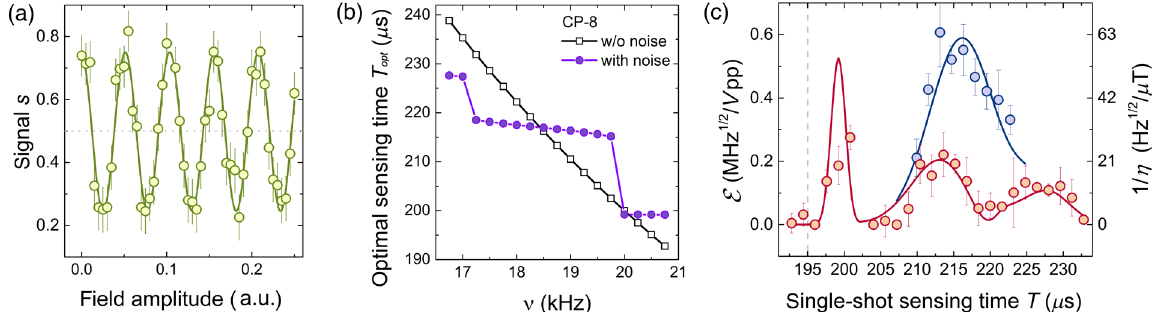
FIG. 2. Optimized sensing of monochromatic fields. (a) Experimental signal measured in the presence of a monochromatic target ac magnetic field, b ð t Þ ¼ b cos ð 2 πν t þ α Þ , with ν ¼ 9 . 24 kHz and α ¼ 0 , as a function of the target magnetic field amplitude b . Here, the spin sensor is controlled with a Carr-Purcell sequence of n ¼ 4 equidistant π pulses. Dots are the experimental data, the curve is a cosinusoidal fit. Error bars are the statistical errors over 2 × 10 5 repeated measurements. (b) Theoretical prediction of the optimal sensing time of a Carr-Purcell sequence of n ¼ 8 equidistant π pulses (CP- 8 ), calculated for a target ac magnetic field b ð t Þ ¼ b cos ð 2 πν t þ α Þ , as a function of the ac frequency ν . The black empty squares are the optimized solutions of the sensing problem when neglecting the presence of the noisy environment, and the black curve represents the expected optimal time, T n= ð 2 ν Þ , with no fitting parameters. Purple dots are optimized solutions including the noise-induced decoherence of the spin qubit opt ¼ (the line is a guide to the eye). (c) Inverse of sensitivity, in the presence of a cosinusoidal field b ð t Þ of frequency ν 0 ¼ 20 . 5 kHz under CP control, with α ¼ 0 (in red), and with α ¼ 102 ° (that is, an initial delay time t 0 ¼ 0 . 28 = ν 0 ) resulting from optimization (in blue). Dots are experimental value of E (left side vertical axis — see text), lines are theoretical 1 = η (right side vertical axis). The experimental error bars come from the slope uncertainty of the experimental signal s